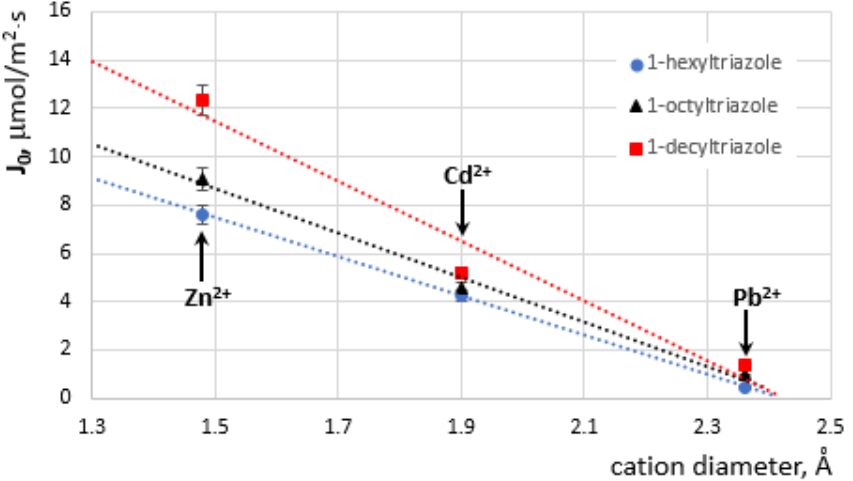
Figure 6. Dependence of the initial flux value of Zn(II), Cd(II), and Pb(II) ion transport by PIM containing 1–hexyltriazole ( 1 ), 1–octyltriazole ( 2 ), and 1–decyltriazole ( 3 ) as carriers. The diameters of the Zn(II), Cd(II), and Pb(II) are 1.48Å , 1.90Å , and 2.36Å , respec- tively [43]. As the cation diameter increases, the value of the initial ion fluxes decreases (Figure 6).